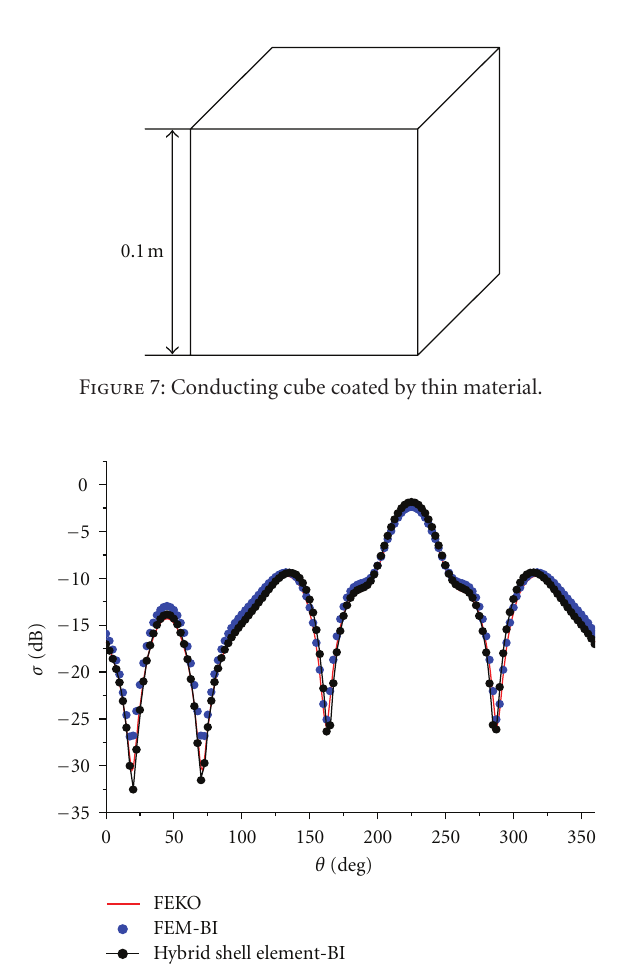
Figure 6: The bistatic RCS of the conducting sphere coated by thin dielectric material by the hybrid shell element with BI.